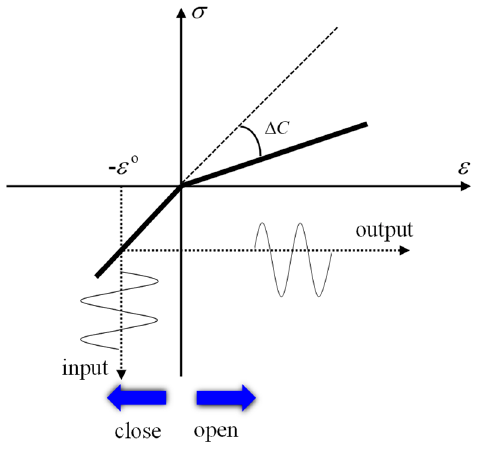
Figure 1. The bilinear constitutive relation between stress and strain.